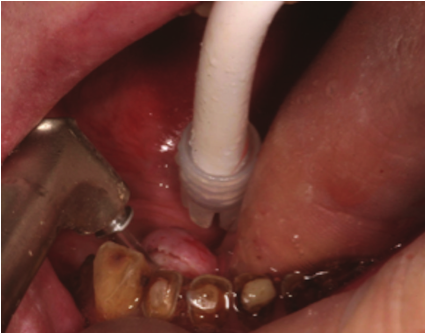
Figure 2: TM. Mucosal incision (sapphire tip).